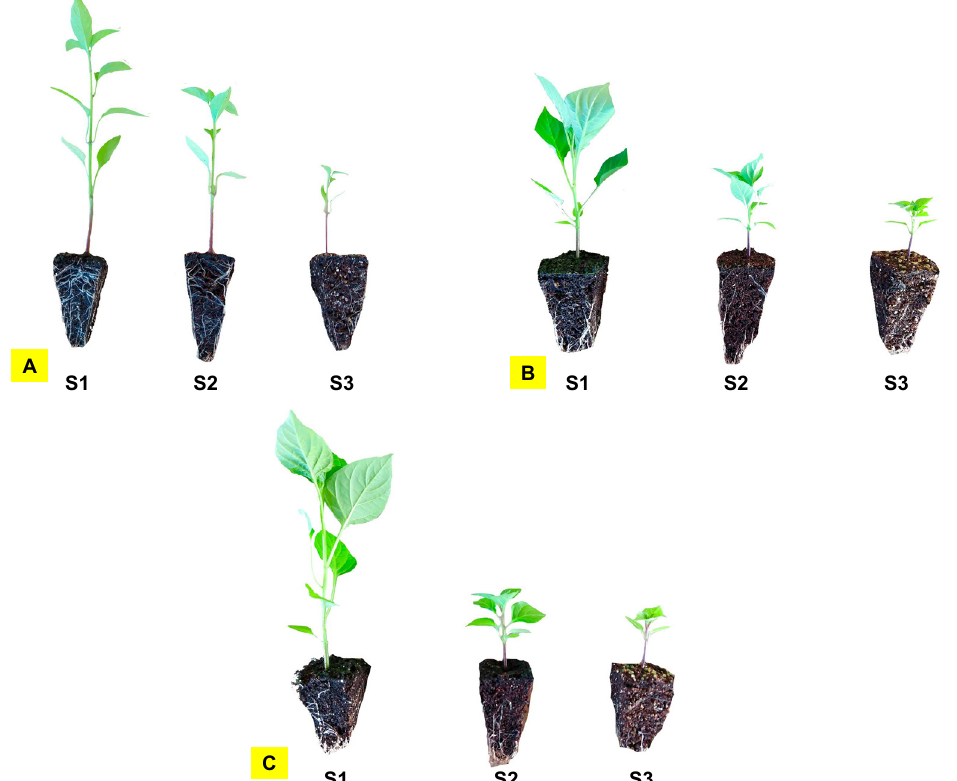
Fig. 1 Pepper seedlings of the ENAS-5007 (A), ENAS-5031 (B) and ENAS-5032 (C) genotypes at 43 days after sowing in 100% Millicompost (S1), 50% Millicompost + 50% Coconut fiber (S2) and Carolina Organic commer- cial substrate